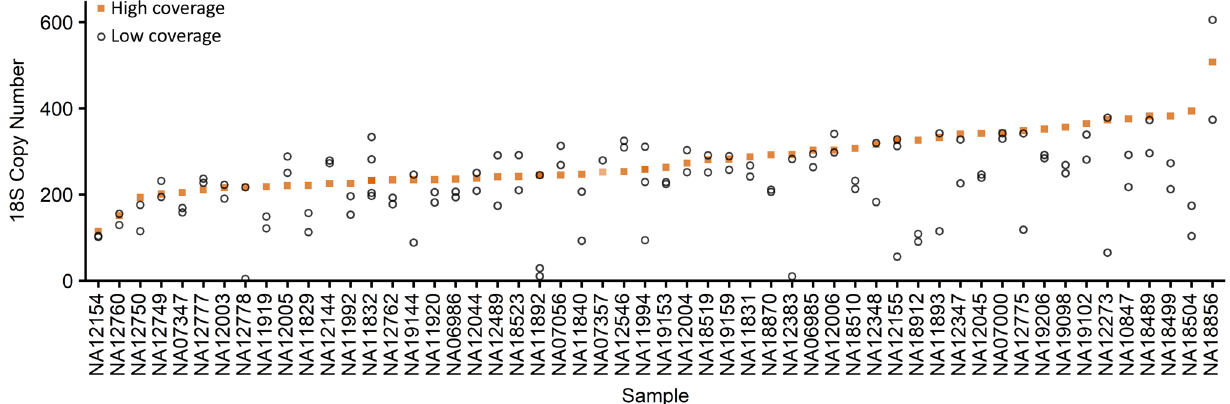
Figure 3. Comparison of 18S copy number estimates for different libraries made from the same cell lines. Of the low-coverage 1000 Genomes Project samples, 54 contained data from multiple sequencing libraries. Orange squares denote the high-coverage 1000 Genomes Project estimate. Open black circles indicate individual library estimates for each sample. Samples are ordered by high-coverage 18S